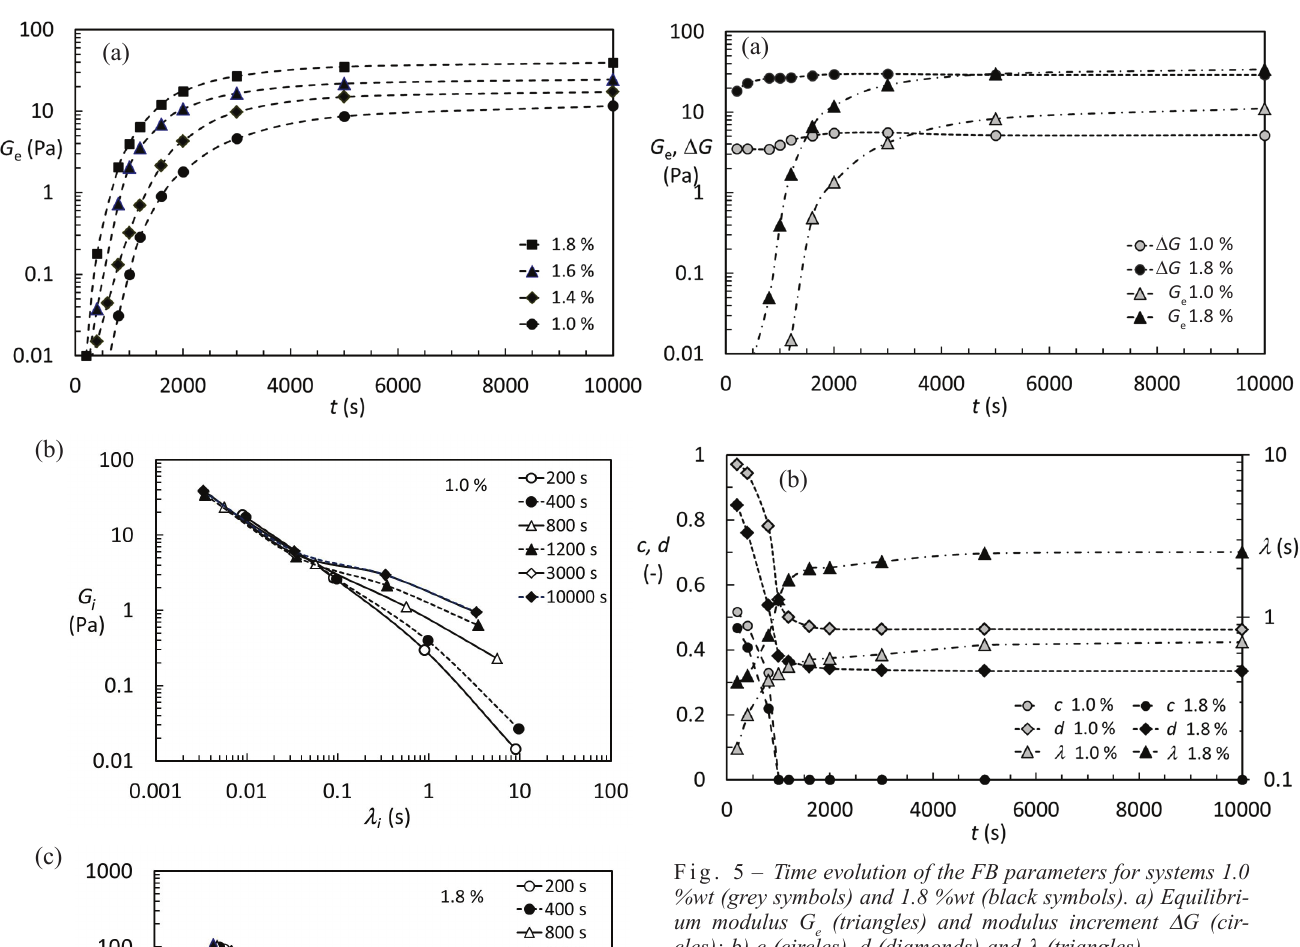
Fig. 5 – Time evolution of the FB parameters for systems 1.0 %wt (grey symbols) and 1.8 %wt (black symbols). a) Equilibri- um modulus G (triangles) and modulus increment D G (cir- e cles); b) c (circles), d (diamonds) and l